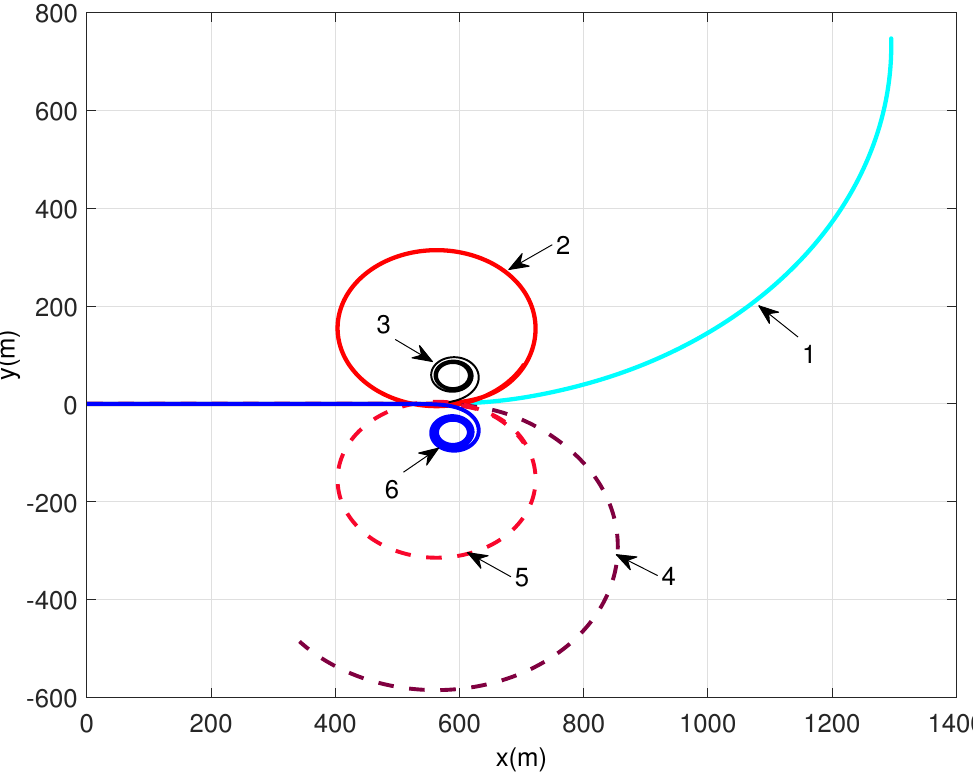
Figure 4. Trajectories of the parafoil system without